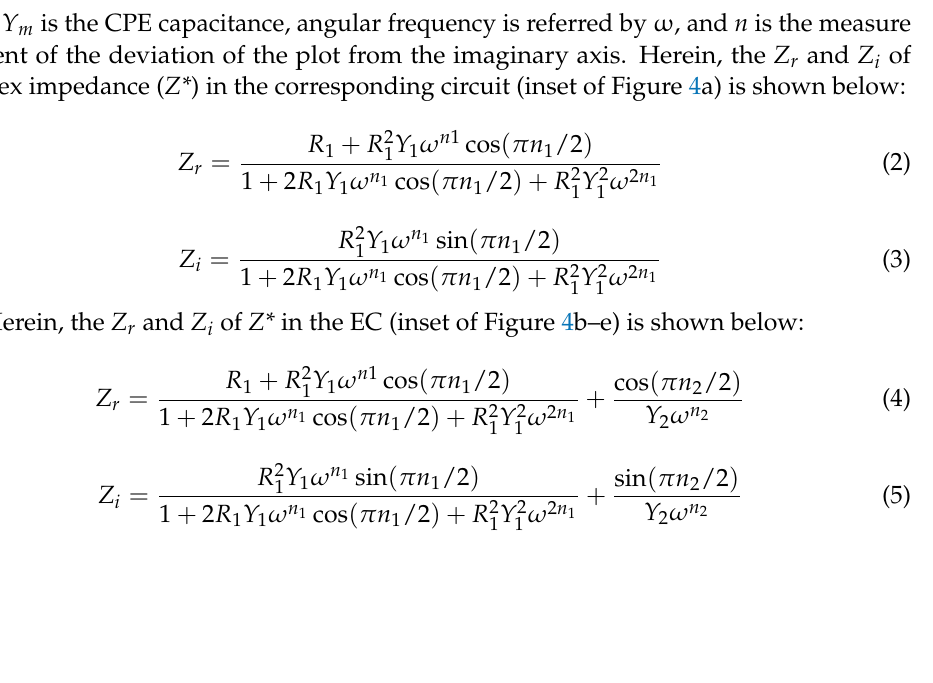
Figure 3. XRD pattern of MC:NaBr solid electrolyte films.